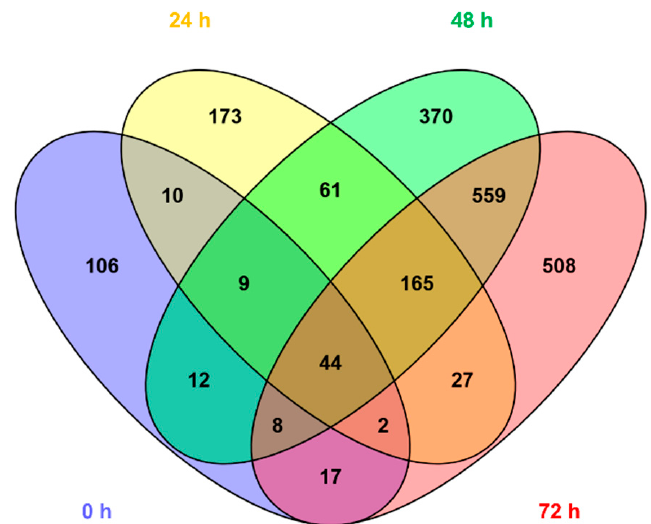
Figure 3. Venn diagram showing the overlap among altered metabolic features in plasma samples collected 0, 24, 48, and 72 h. Note: Blood samples were extracted at birth and at 24, 48, and 72 h after the administration of the first dose of medication /